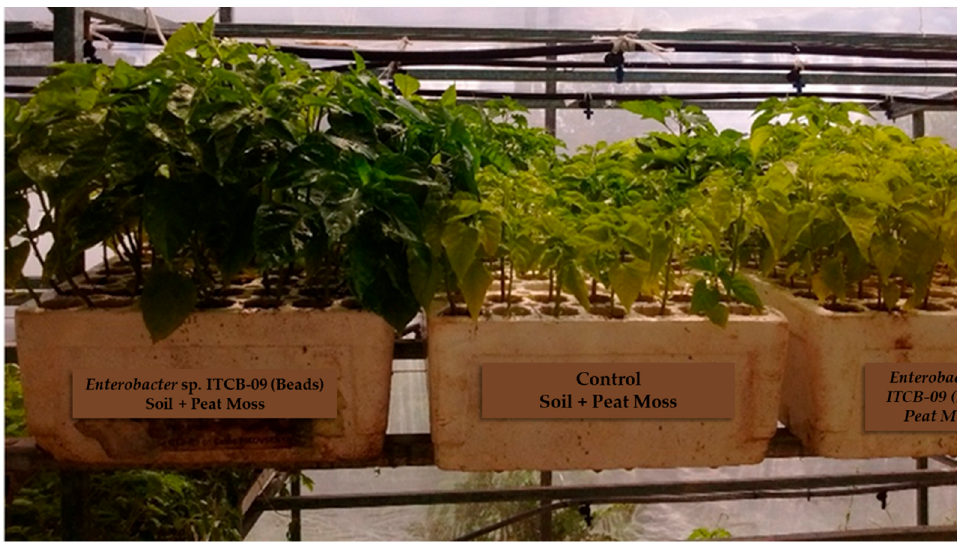
Figure 5. The response of Capsicum chinense Jacq. plants after 60 days of greenhouse cultivation.